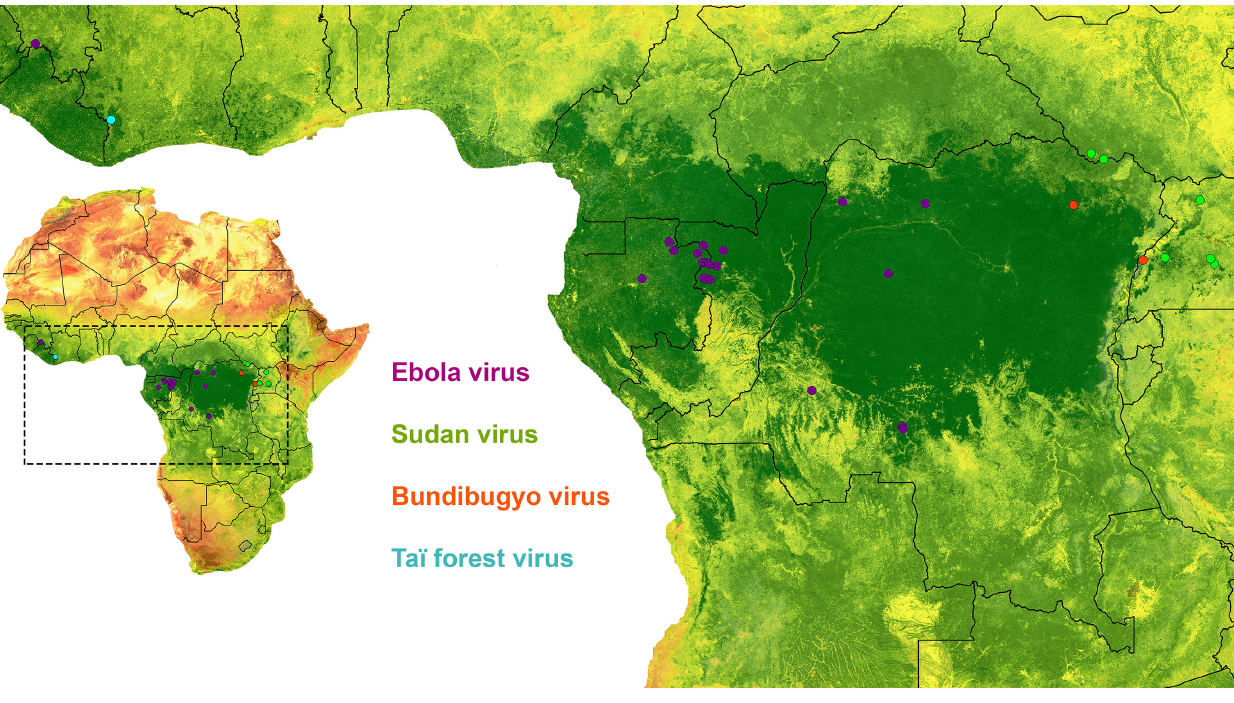
PLOS Pathogens | DOI:10.1371/journal.ppat.1005780 August 5,